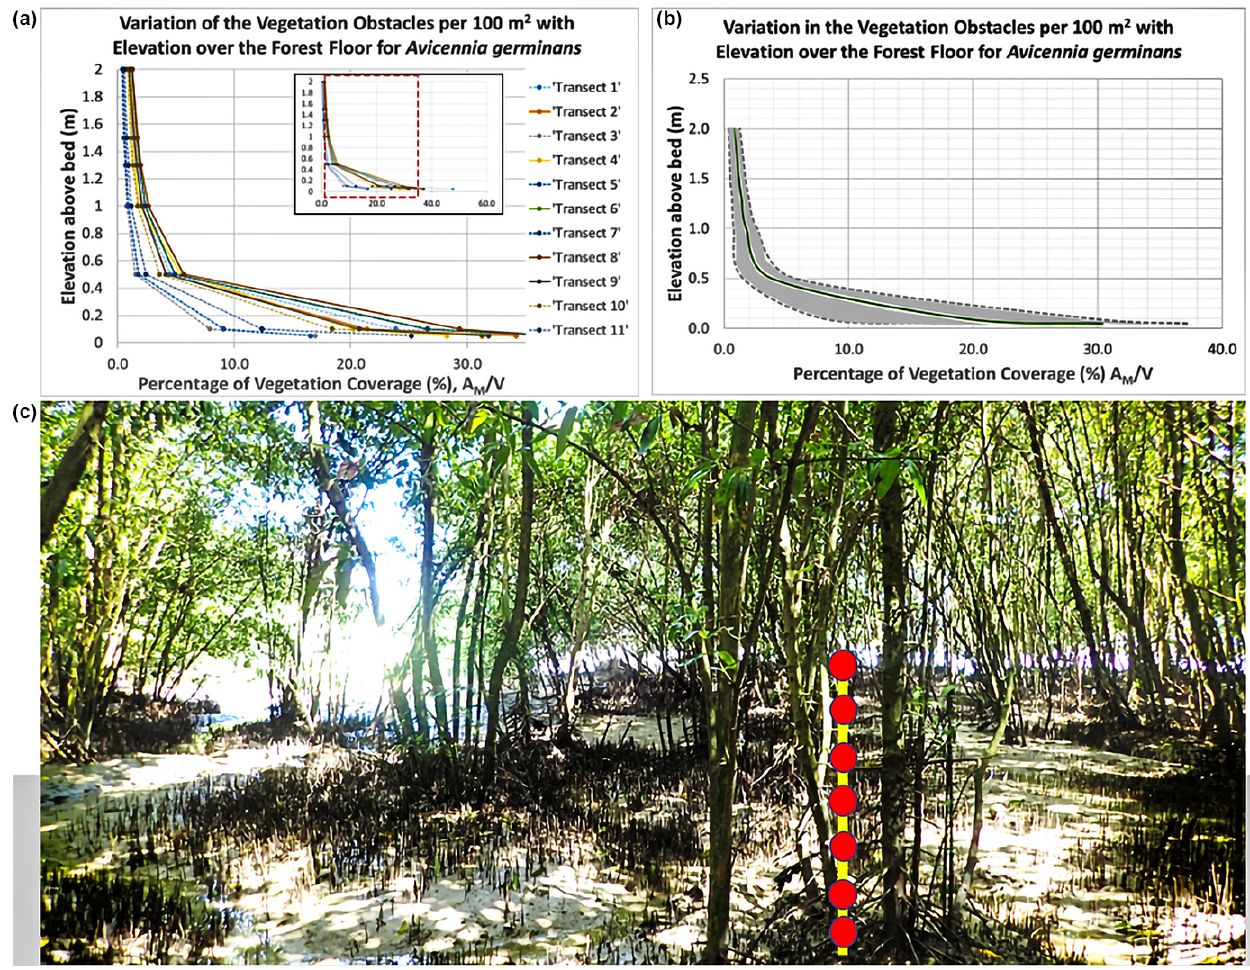
Figure 6. Variation in the vegetation density ( A M /V ) with elevation above the forest floor expressed as a percentage. (a) Horizontal vegetation density reduces with increasing elevation above the forest floor. (b) Vegetation characteristics for Avicennia germinans with the measurement indicators starting from 0.05m and culminating at